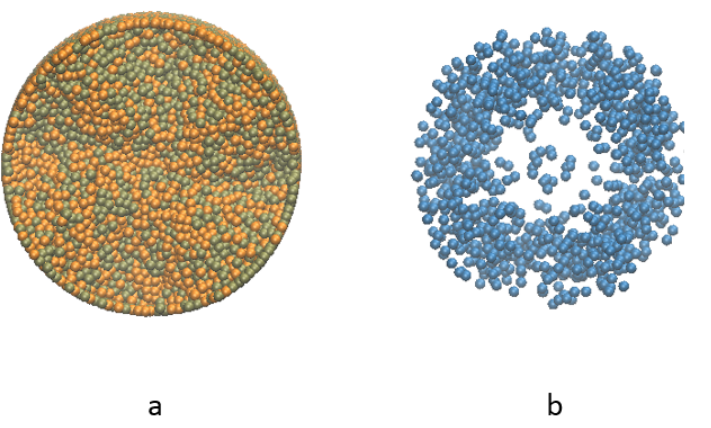
Figure 9. Topview of particle distribution after mixing ( a ) solid particles and ( b ) liquid particles.